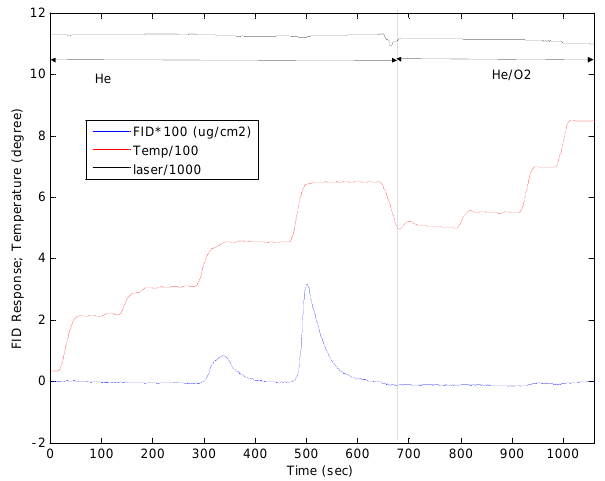
Fig. 3. Thermosgram from the analysis of natural calcite from Spain (grain dimension ≤ 300µm) with the EUSAAR 2